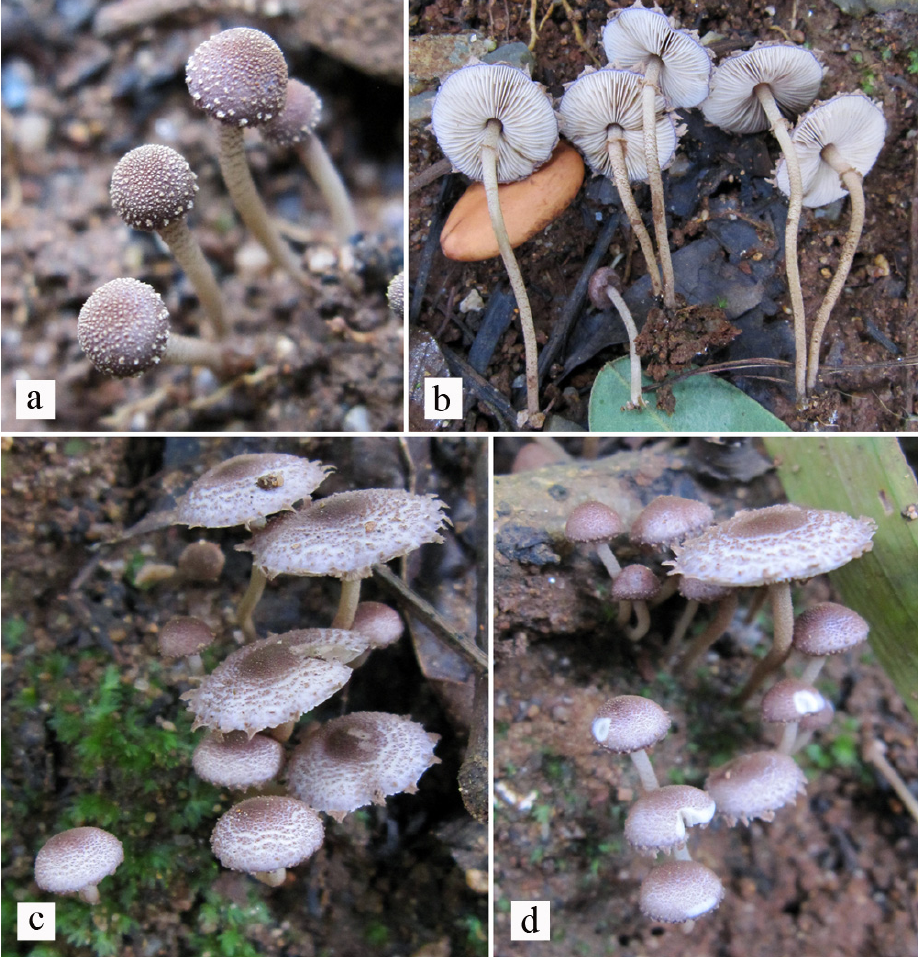
Figure 27. Fresh basidiomata of Xanthagaricus purpureosquamulosus . ( a – c ) MFLU 19-2354 (holotype). ( d ) MFLU 192356.